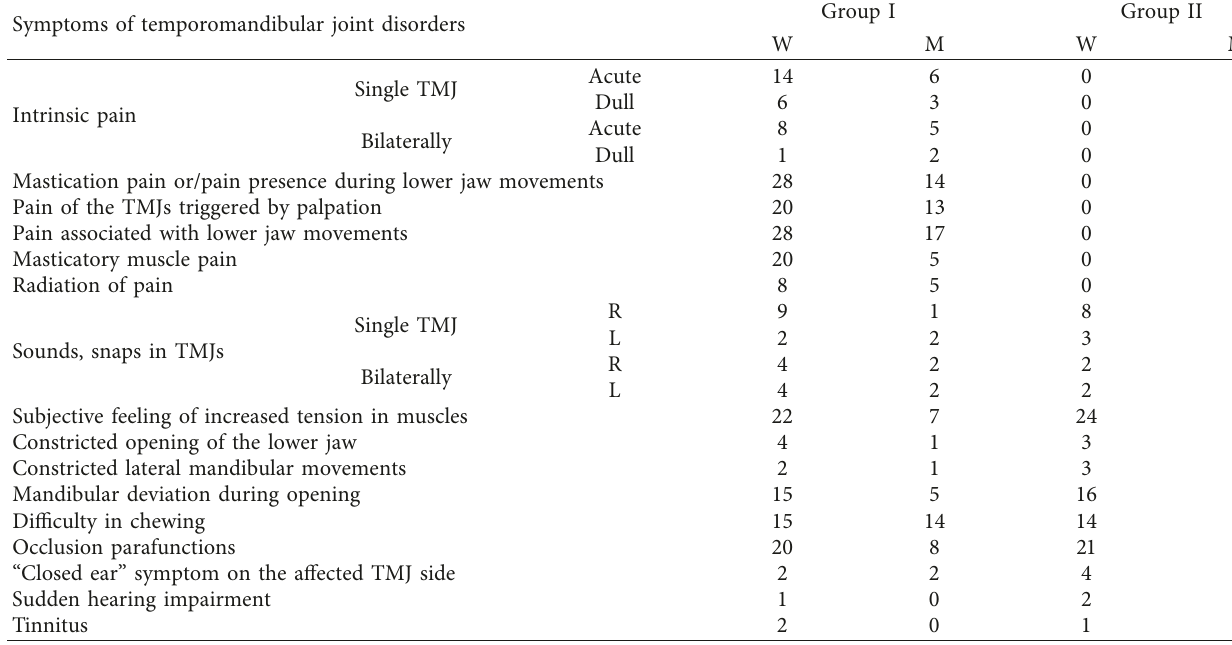
Table 1: A summary of symptoms obtained during functional examination of stomatognathic system conducted in both groups. Symptoms of temporomandibular joint disorders